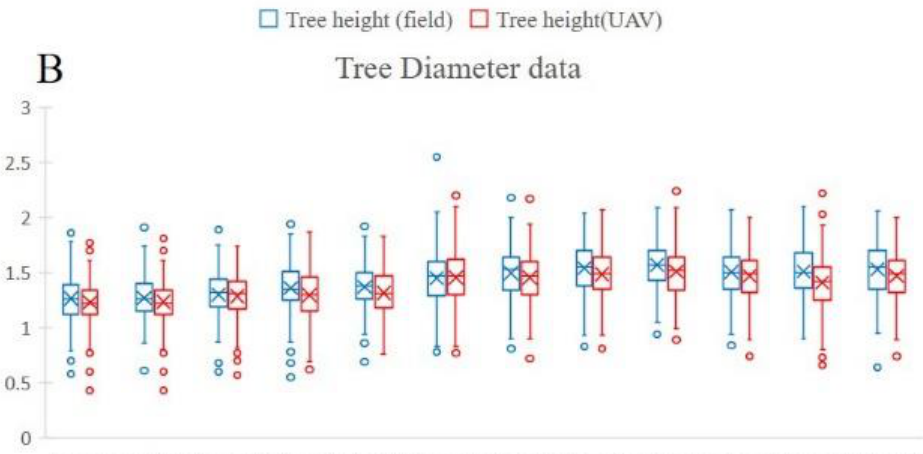
Figure 4. Estimated x measured plant heights in the field ( A ). Estimated x measured plant crown diameters ( B ).